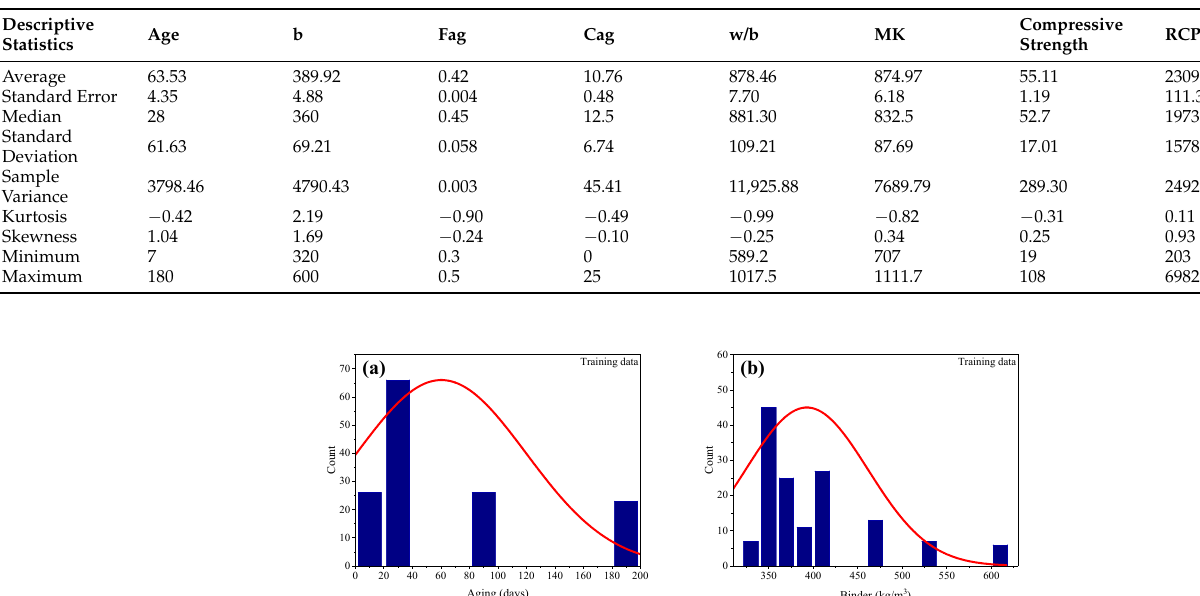
Table 1. Descriptive statistics of the input variables.